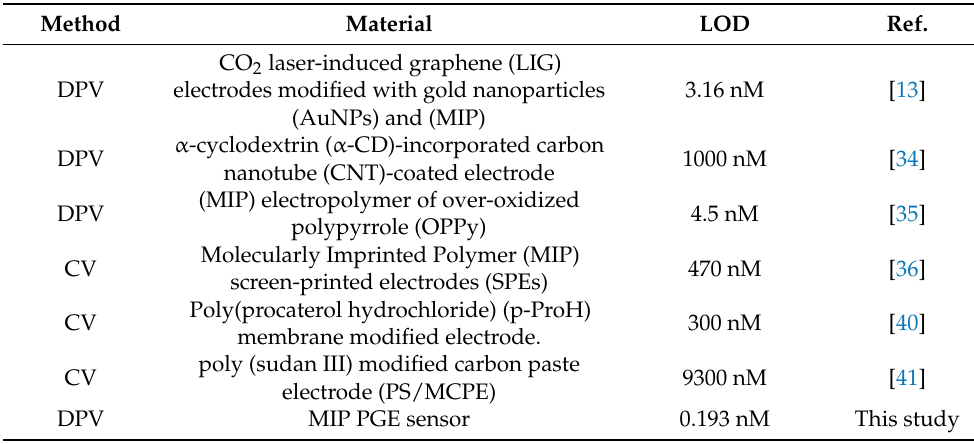
Table 3. Different modified electrode sensors for DA